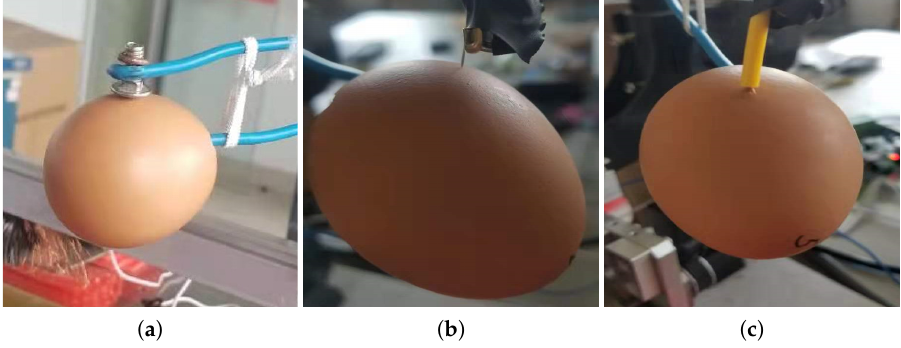
Figure 8. Tip electrode experimental set-up. ( a ) Smooth electrode. ( b ) Tip electrode. ( c ) Multi-strand tip